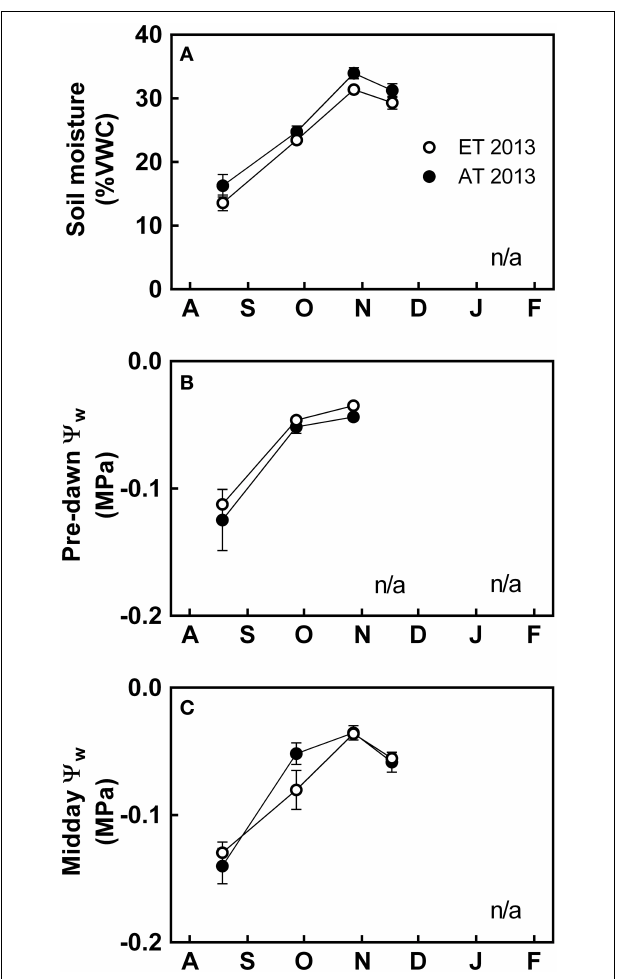
FIGURE 4 | Effect of elevated temperature on soil water availability and osmotic stress in field-grown white pine seedlings during autumn. (A) Soil moisture content, expressed in percent volumetric water content (% VWC); (B) pre-dawn water potential ( 9 w ); and (C) midday 9 w measured during 2013. AT and ET, seedlings grown at ambient and elevated temperature, respectively. n/a indicates points where water potential was not assessed because the equipment did not operate at sub-freezing temperatures in the field. Each data point represents the average of 5 plots, ±